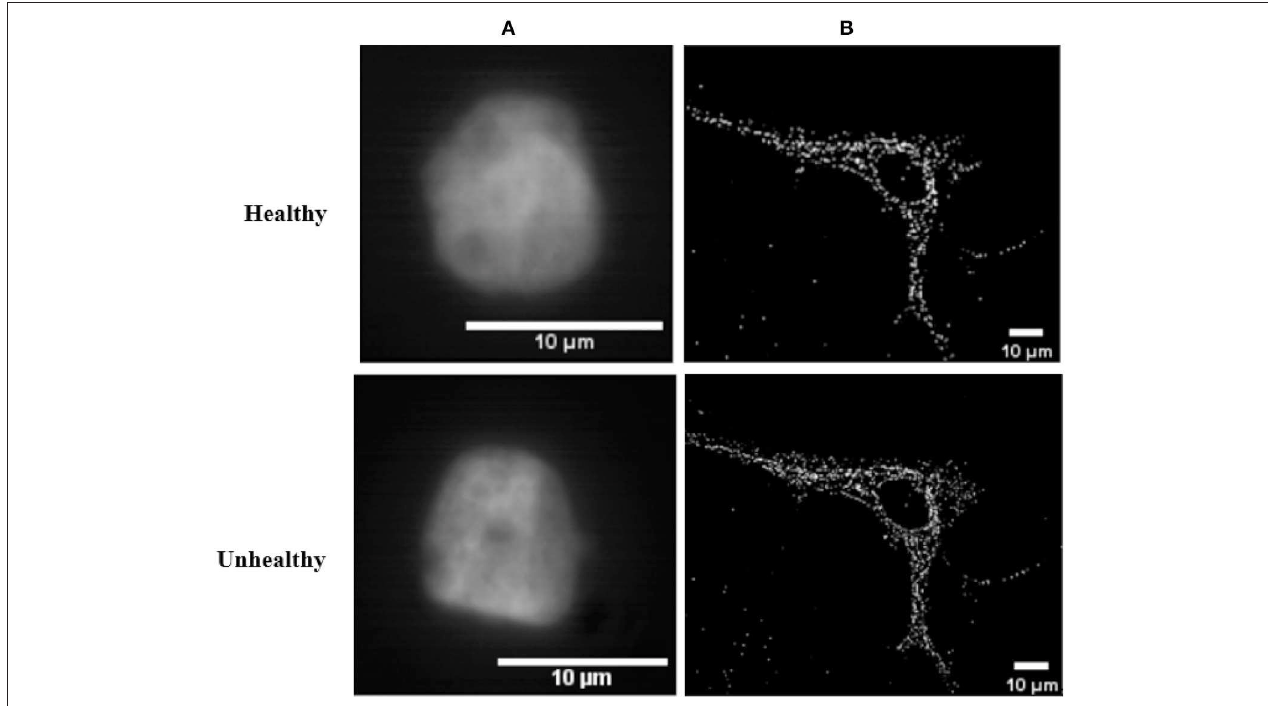
FIGURE 2 | Real 2D images of healthy and unhealthy nuclei of cells from different microscopy techniques. (A) Nuclei of breast cells images acquired by an Aurox Clarity structured illumination/spinning disk laser-free confocal microscopy system. The lens used was a 63 × 1.4NA Oil objective, with for a 583 nm excitation and 631 nm emission wavelengths, and looking at mCherry labeled histone-H2B. (B) Nucleoids of skin fibroblast mitochondria stained with fluorescein isothiocyanate (FITC) and acquired with super-resolved stochastic optical reconstruction microscopy